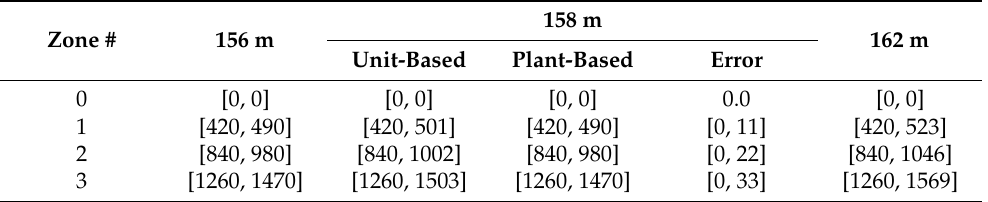
Table 6. Errors in interpolation with Nuozhadu as an